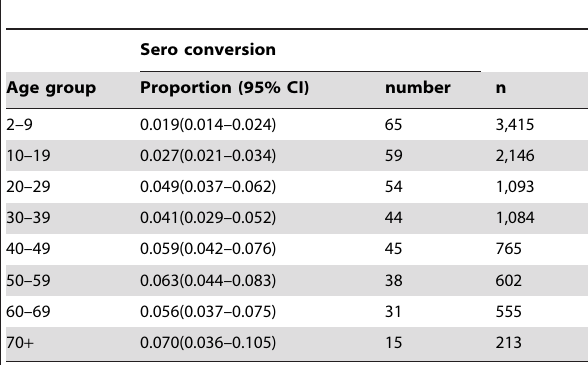
Table 2. Trends by age group in sero conversion to either DAT or